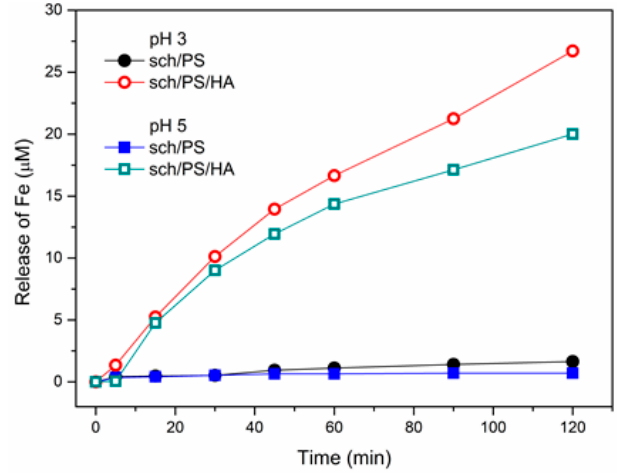
Figure 4. Release files of dissolved iron from schwertmannite during the degradation of RhB under various pH conditions. Concentrations: [Sch] = 0.5 g/L, [RhB] = 25 mM, [PS] = 5 mM, and [HA] = 0.5 mM.